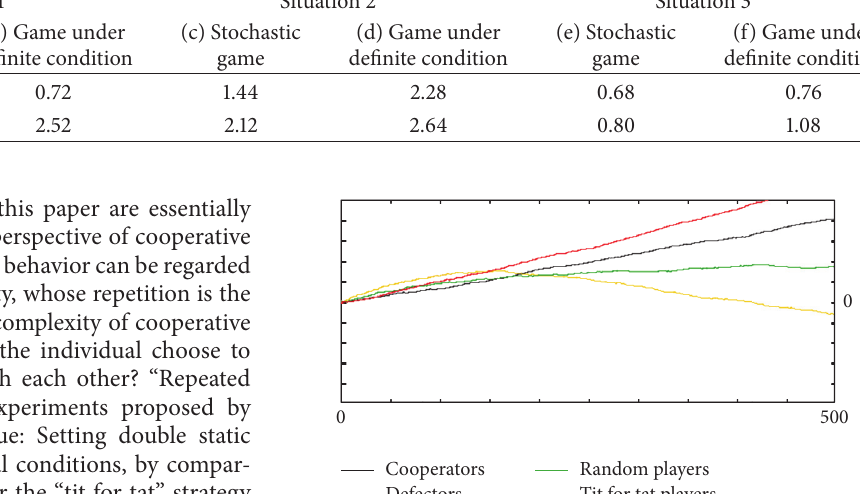
Table 5: Required time comparison of stochastic game result and game under definite condition. Strategy ratio